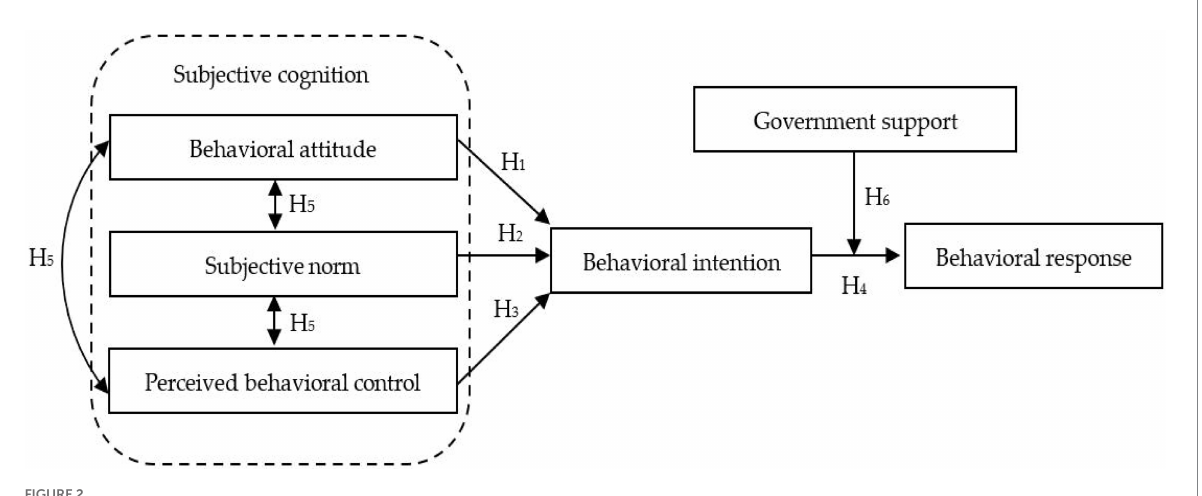
FIGURE 2 Theoretical analysis